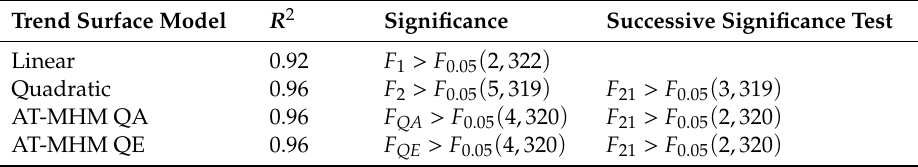
Table 3. The statistical test results of models constructed from the previous